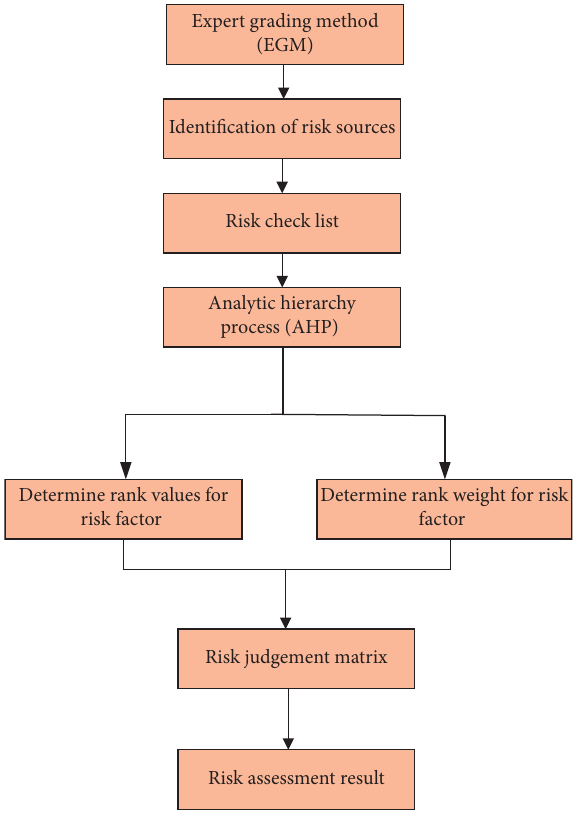
Figure 1: Steps of the EGM-AHP